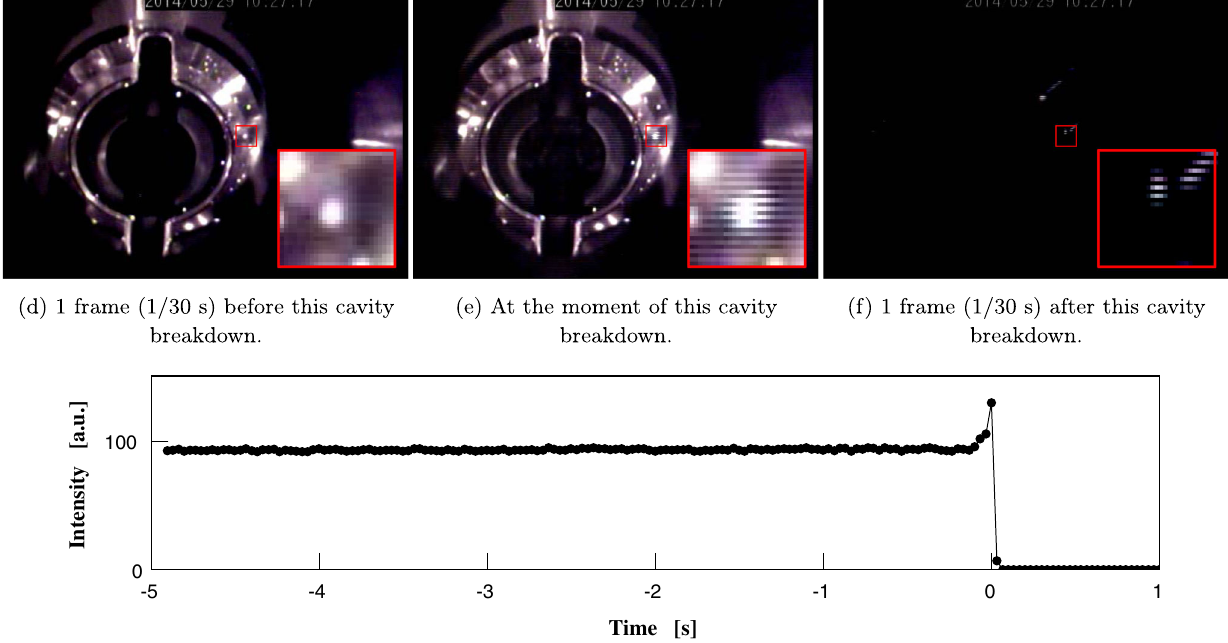
FIG. 14. Example of spot-type explosion events without a stable bright spot, accompanied by the sudden appearance of a new bright spot. (a) – (f) are snapshots, in chronological order, of the TEP recorded with TV camera 2 during the rf conditioning. The insets are magnified views of the region outlined by a red square. There was an explosion at 3 o ’ clock [indicated by the red square in (b) – (e)] at V ¼ 0 . 80 MV; however, no clear bright spot was present in this region until 4 frames ( 4 = 30 s) before this cavity breakdown, as c indicated by the red square in (a). A new small bright spot appeared in this region 3 frames (0.1 s) before this cavity breakdown, as indicated by the red square in (b). A clear spike was observed in the intensity of the region outlined by a red square at the moment of this cavity breakdown for four frames, as shown in